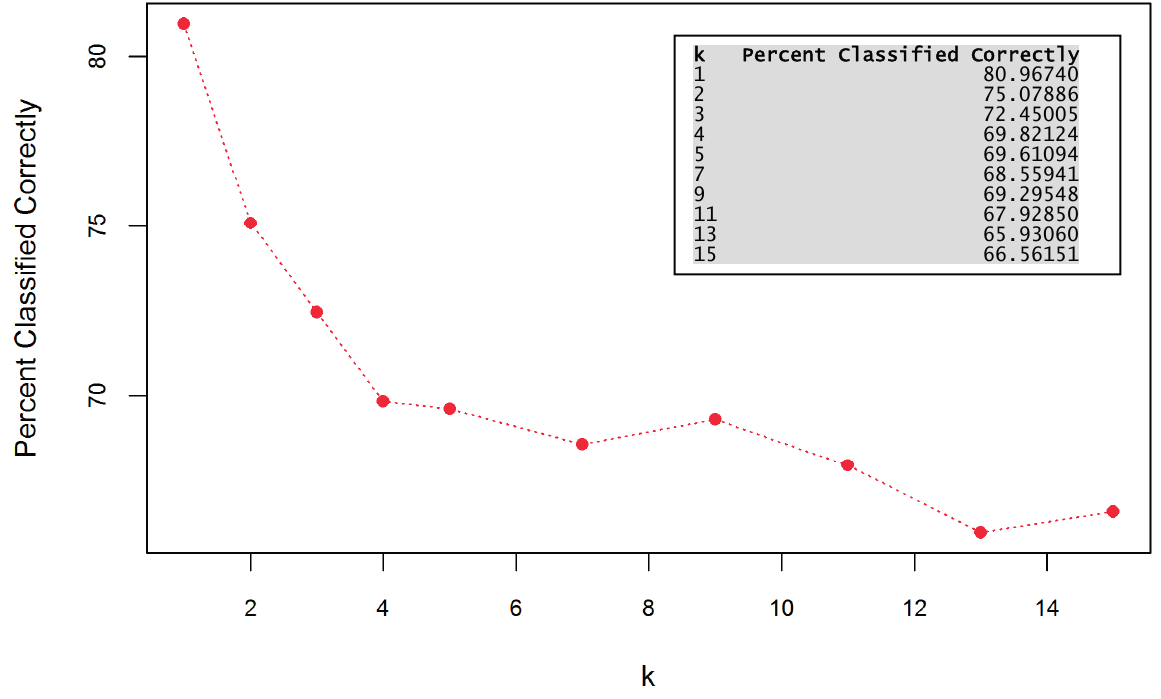
Figure 8. K-NN accuracy for different k